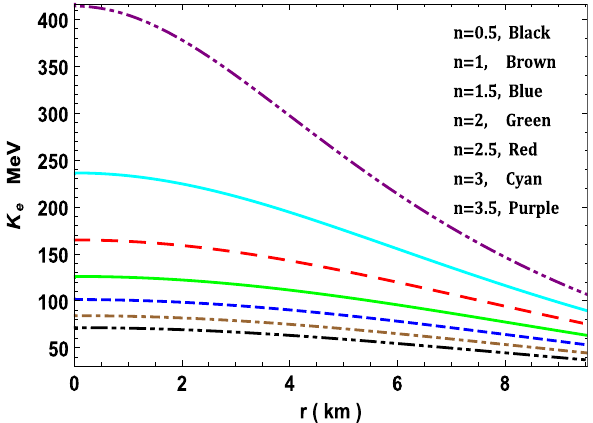
Fig. 17 Variation of K e with radial coordinate r for 4U 1608-52 ( M = 1 . 74 M (cid:9) , R = 9 . 528 km) by taking a = 0 . 001 km − 2 and β = 0 .